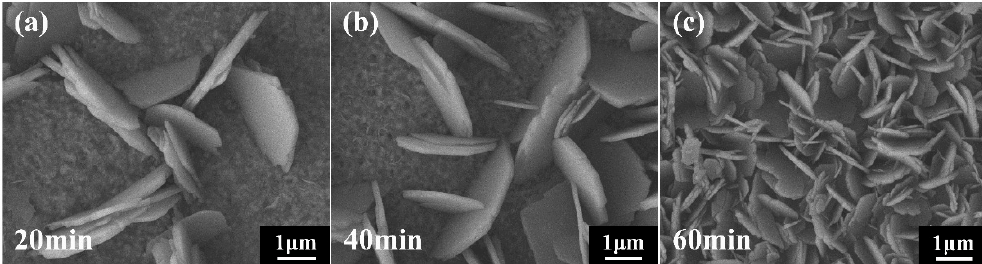
Figure 2. The surface morphology of the Cu 2 (NO 3 )(OH) 3 /ZnO precursors prepared at a fixed Cu 2+ ion concentration (2 mM) and various illumination time: ( a ) 20 min, ( b ) 40 min and ( c ) 60 min.